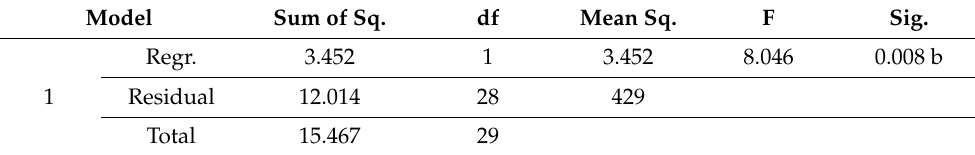
Table 4. E-court information quality and e-court user satisfaction. Model